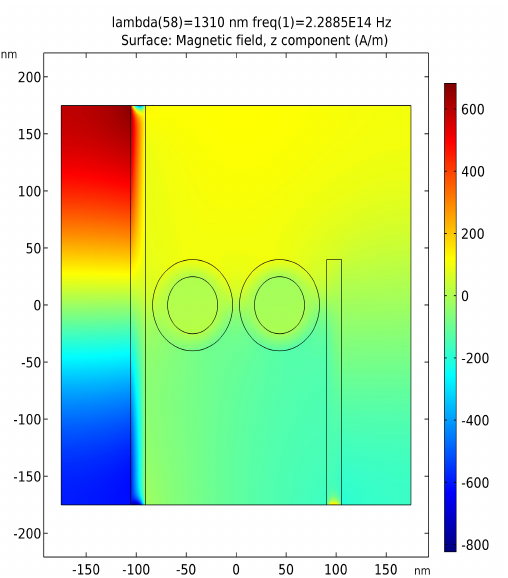
Figure 2: The Magnetic Field Profile in Case of (ON) Output